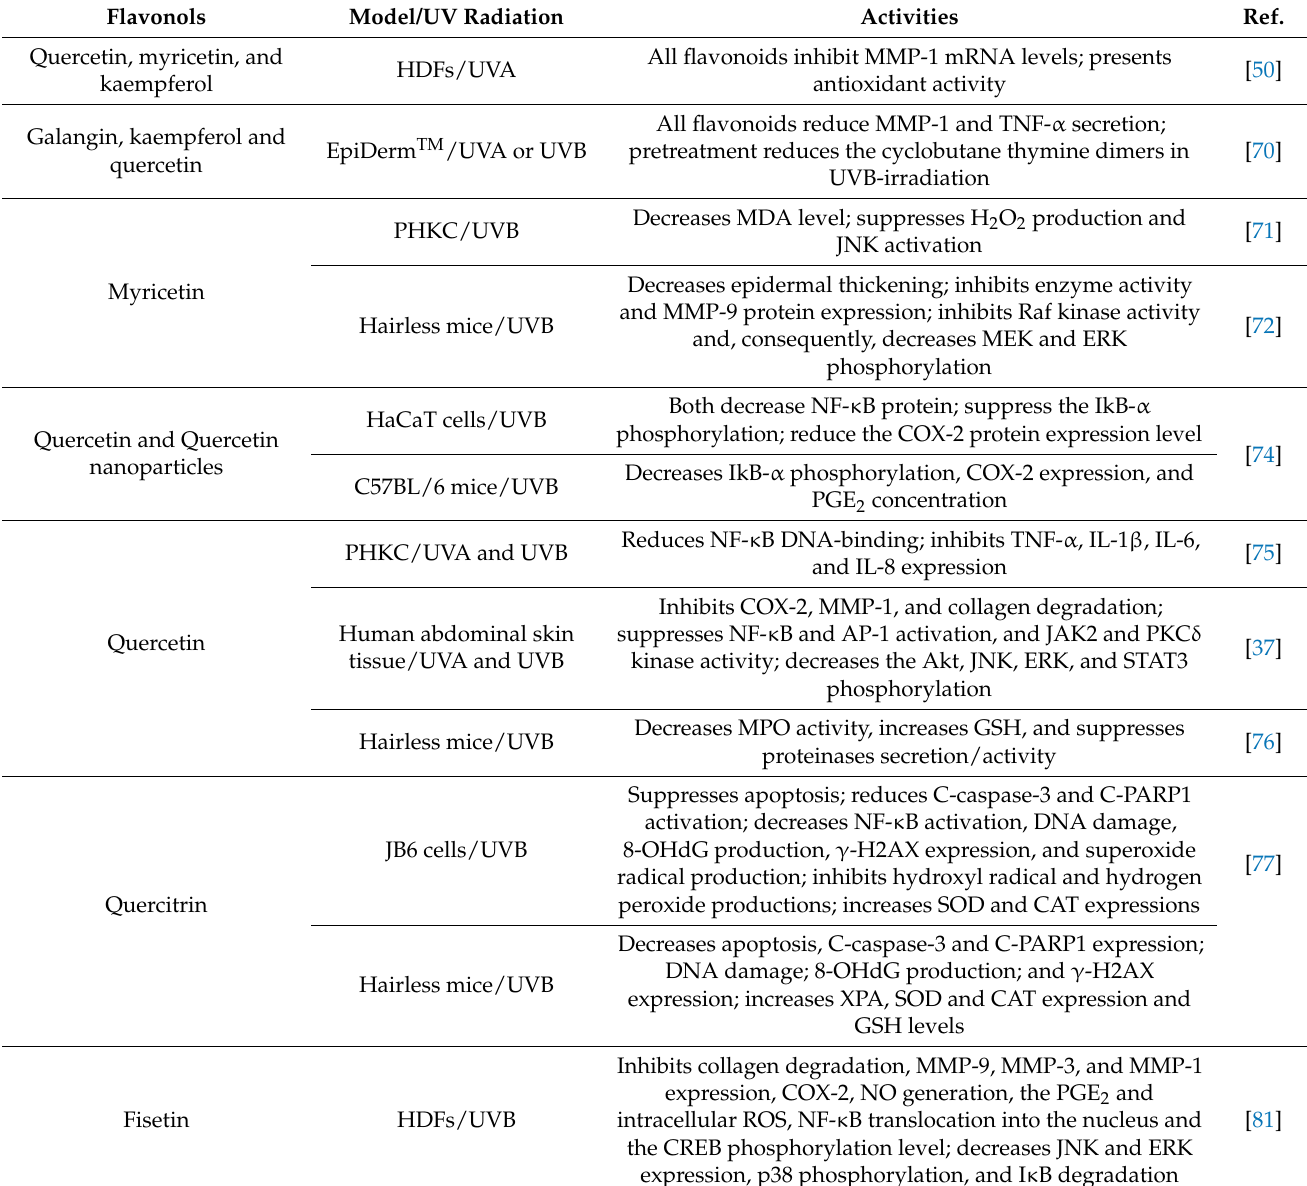
Table 2. Main anti-photoaging effects of flavonols in different study